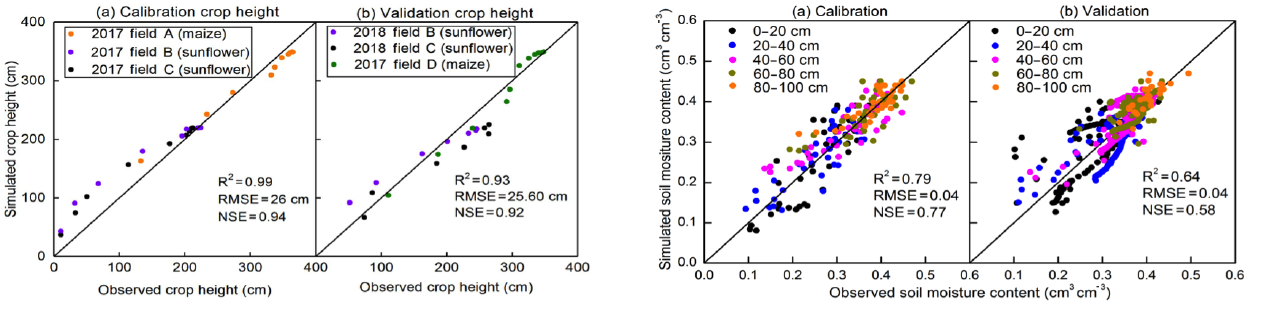
Figure 14. Comparison of predicted and observed soil moisture content: (a) calibration and (b)